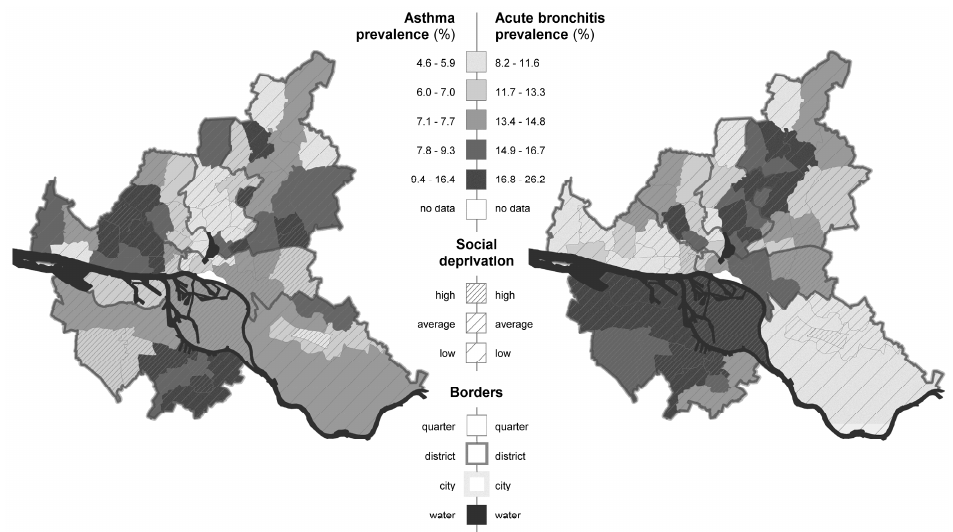
Figure 3. Prevalence rates of asthma and acute bronchitis and spatial distribution of the variable “social deprivation” per borough, Hamburg, Germany, 2011. Treatment prevalence children aged 0–14 years, including both sex. Population are all statutory health insured patients, with at least one contact to a contract physician working in the ambulatory sector per year. Classification of prevalence rates was conducted using quantiles. The variable “social deprivation” was obtained from a previously conducted PCA [26,29].